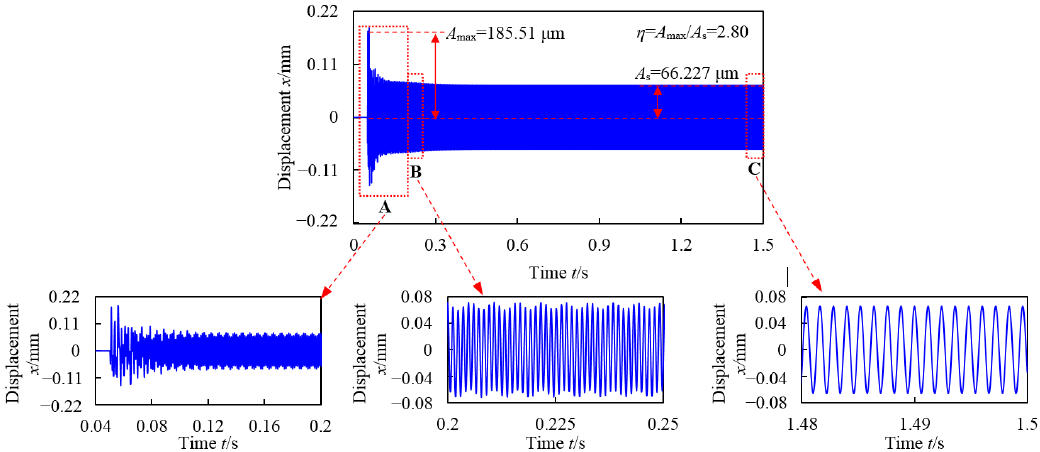
Figure 10. The time-domain response of 1# bearing in the horizontal direction.